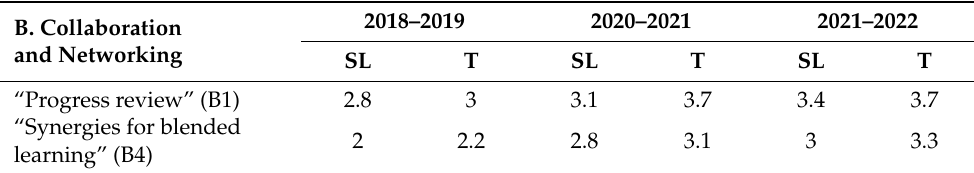
Table 3. Descriptive statistics on Collaboration and